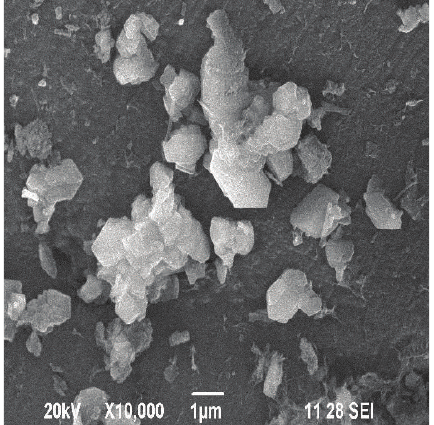
Figure 3: SEM of WSD dust particles.